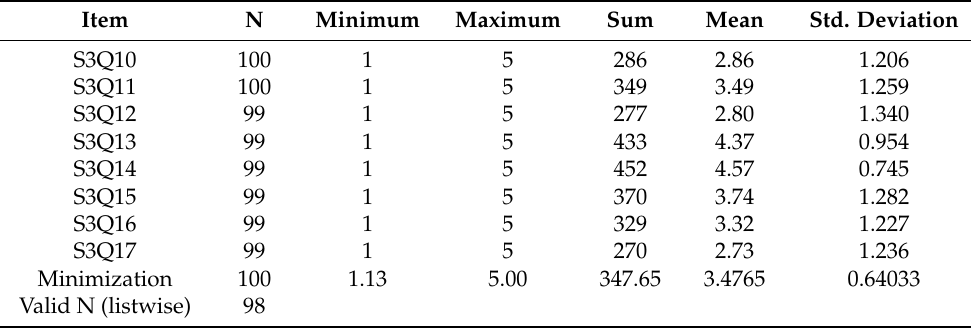
Table 4. Descriptive statistics of perception of Minimization stage.